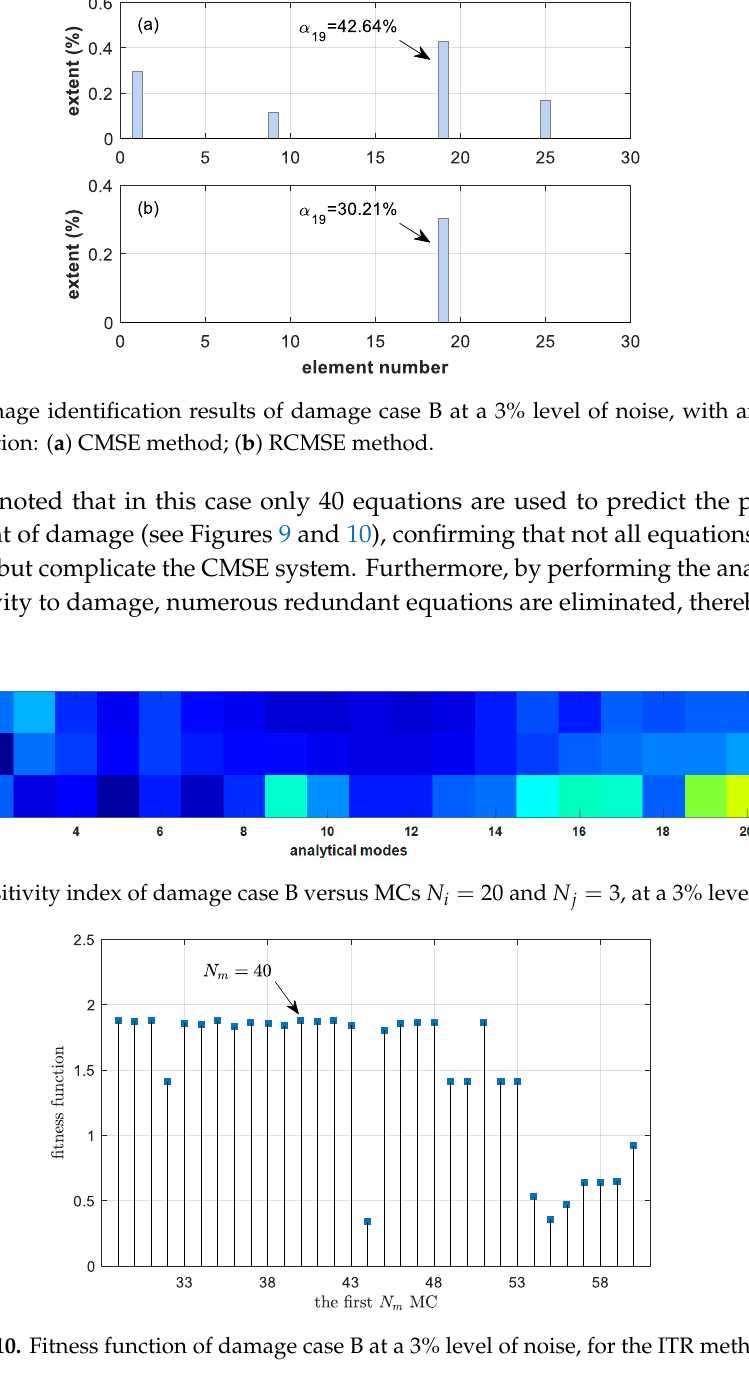
Figure 11. Sensitivity index of damage case C versus MCs 𝑁 𝑖 = 20 and 𝑁 𝑗 = 3 , at a 3% level of noise.